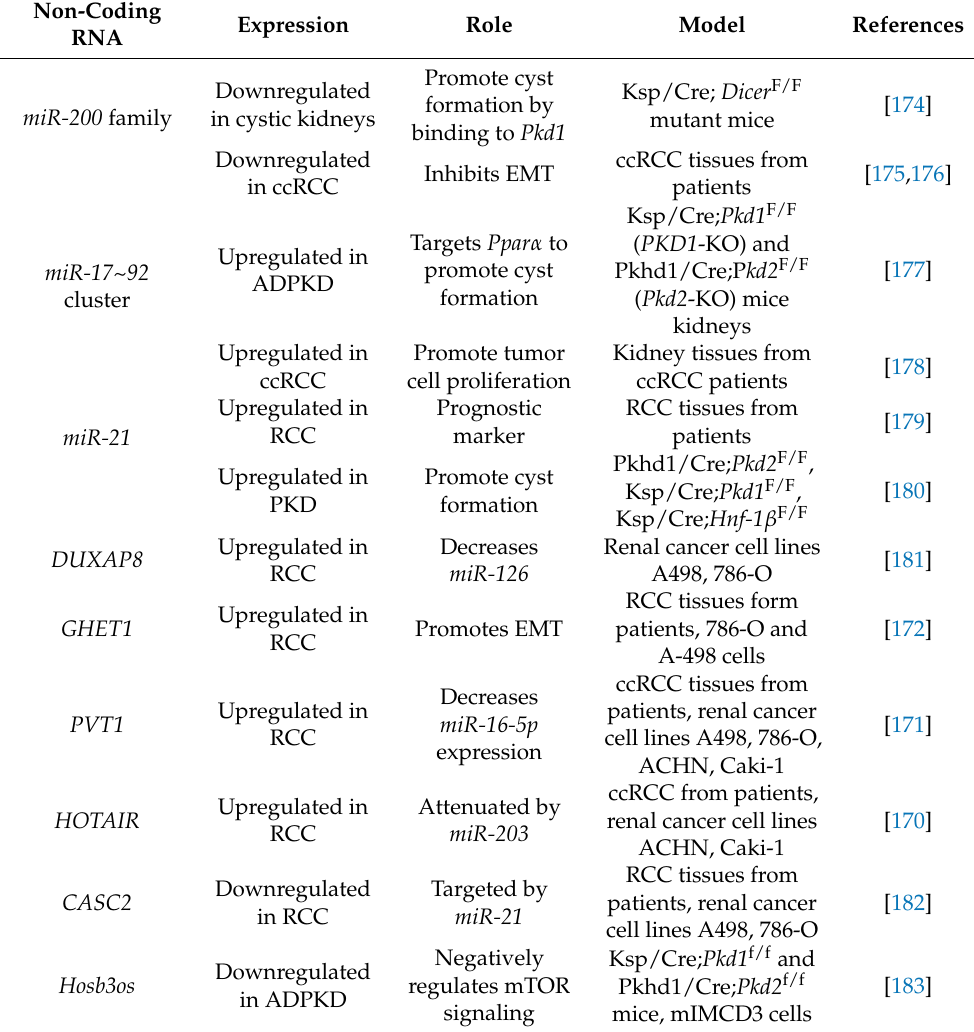
Table 3. Role of Non-Coding RNA Involved in RCC and